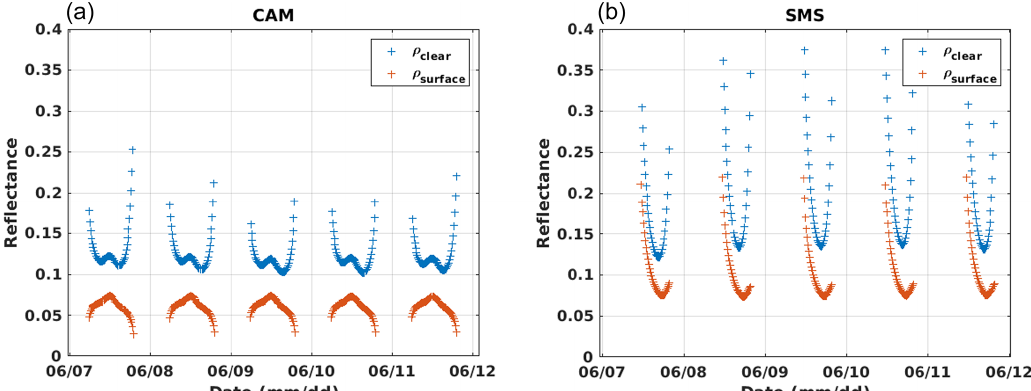
Figure 8. Comparison between simulations of clear-sky reflectances at the top of the atmosphere for the MSG 0.6µm channel ( ρ clear , blue plus signs) and corresponding surface reflectances computed with the RossThick-LiSparse model applied to MODIS MCD43C1v6 BRDF parameters for the channel 646nm ( ρ surface , red plus signs) for 5d in June 2011. (a) Camborne station (CAM); (b) São Martinho da Serra station